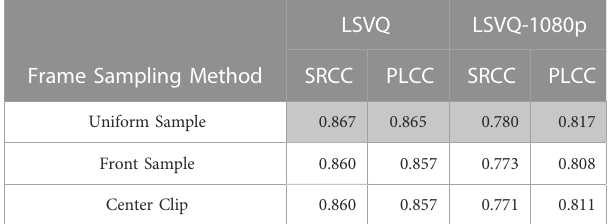
TABLE7Ablationstudyresultsforframesamplingmethod.Our fi nalmethodis marked in